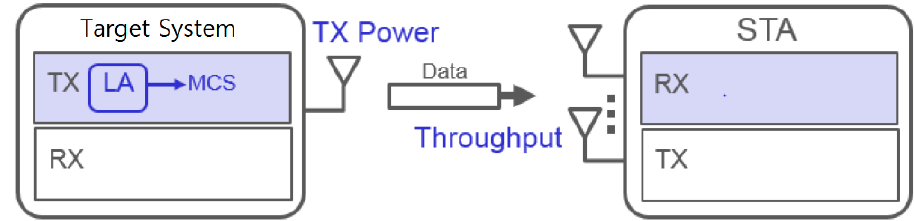
Figure 1. Target system.